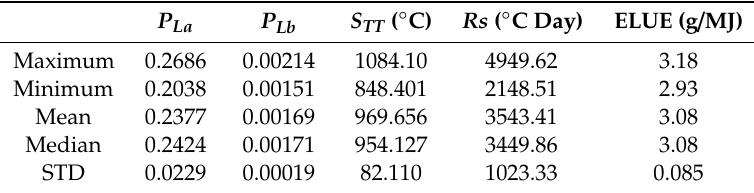
Table 3. The cultivar-specific parameters and effective light use efficiency (ELUE) derived from the initial SAFY calibration. P La is the parameter a of P L function; P Lb is the parameter b of P L function; S TT ( ◦ C) is the sum of temperature for senescence; Rs ( ◦ C day) is the rate of senescence; ELUE (g / MJ) is the effective light-use efficiency.